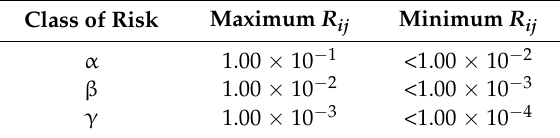
Table 5. Risk distribution of S1, S2, and S3.